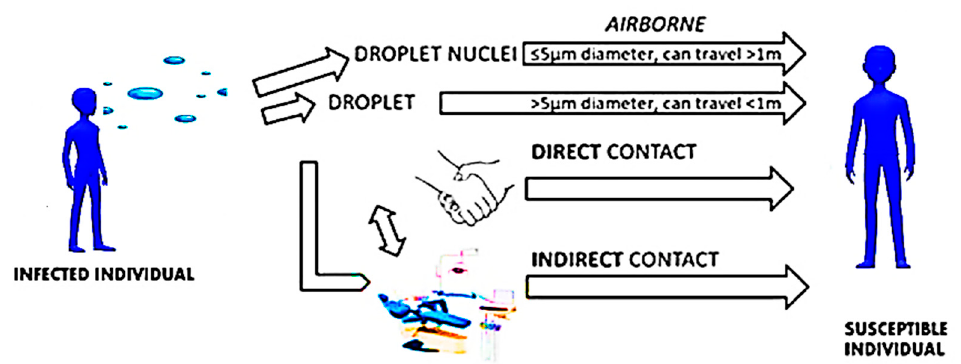
Figure 2. Mechanism of direct and indirect diffusion of the virus Sars-CoV-2 through droplets and aerosol; figure designed by Giovanna Dipalma. aerosol; figure designed by Giovanna